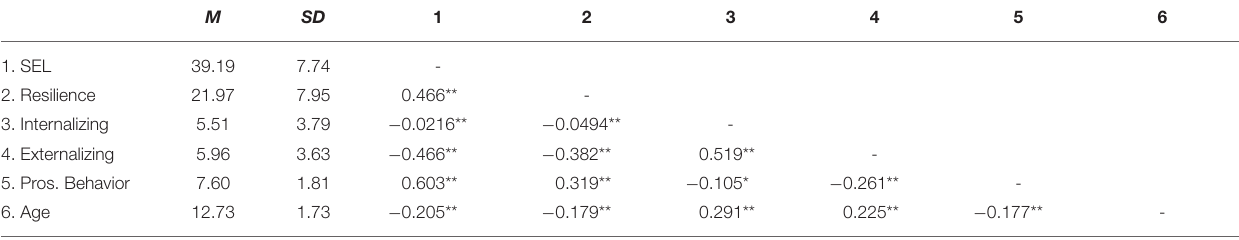
TABLE 1 | Means, standard deviations, and zero-order correlations among the study variables. M SD